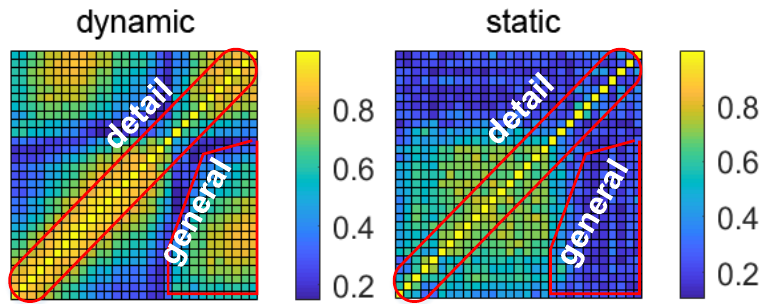
Figure 14. The interest area for extracting detail and general